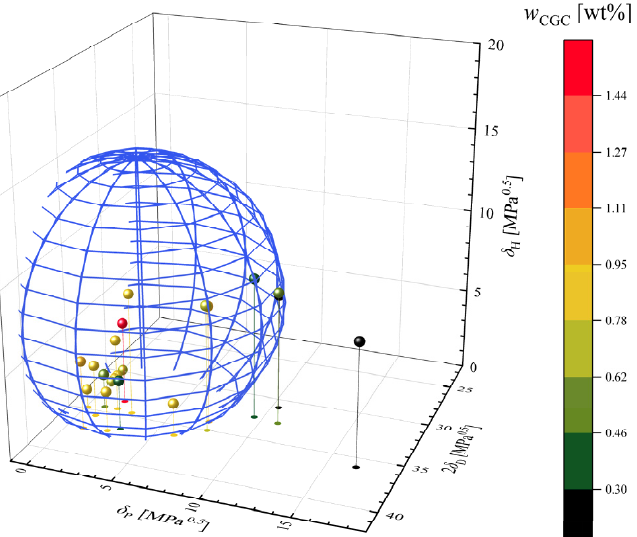
Figure 5. 3D plots of solvent used for 12HSA [30] organogel preparation with their w CGC . Note that black plots indicate that 12HSA was insoluble in the solvent.